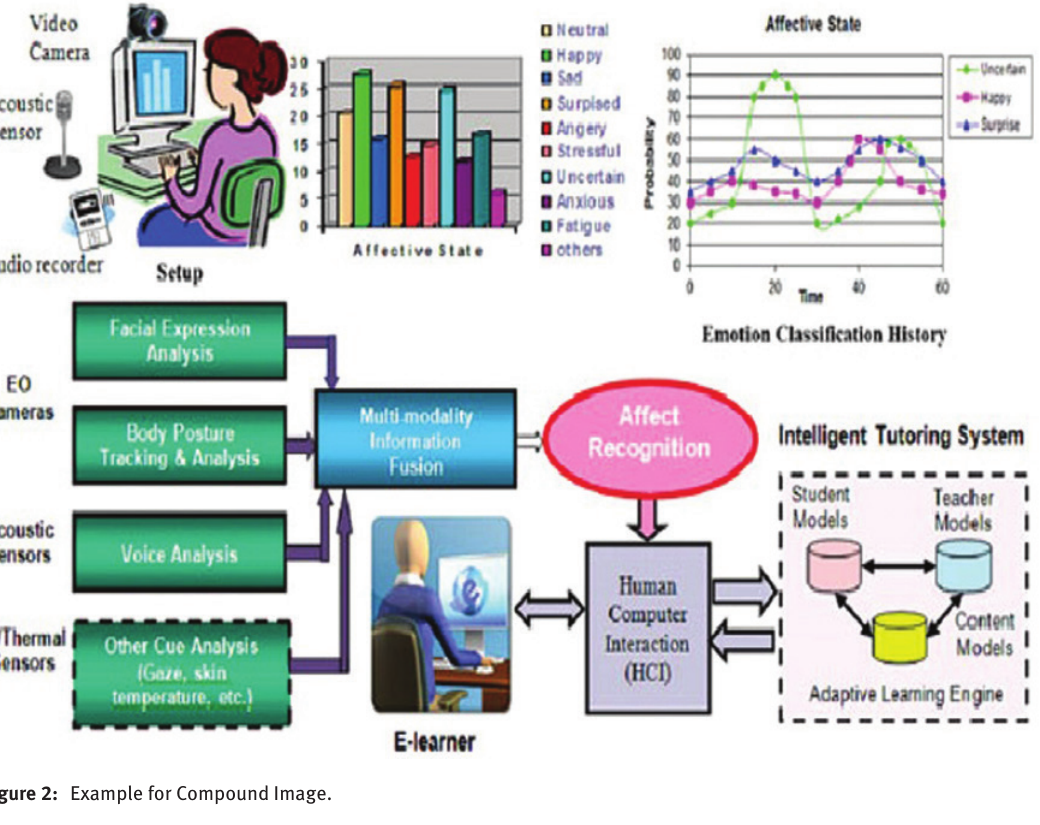
Figure 2: Example for Compound